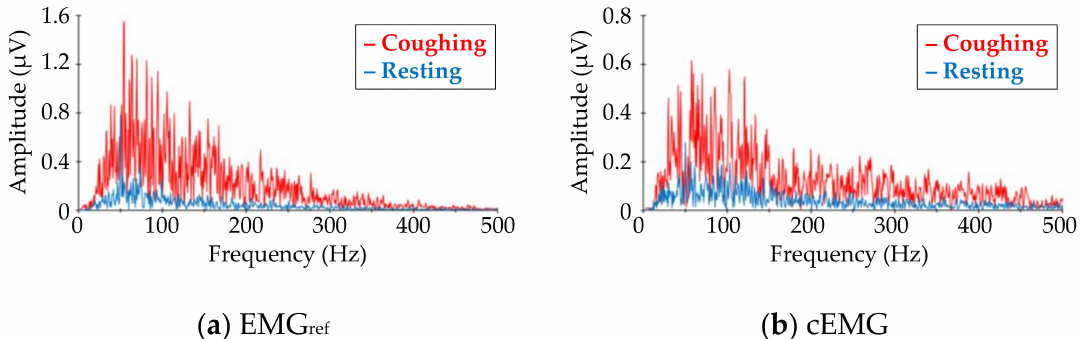
Figure 7. Comparison of frequency–amplitude spectra between coughing and resting segments for ( a ) EMG ref and ( b ) cEMG data shown in Figure 5c. The red line corresponds to the spectra for coughing segments, while the blue line corresponds to that for resting segments. (Subject #B).